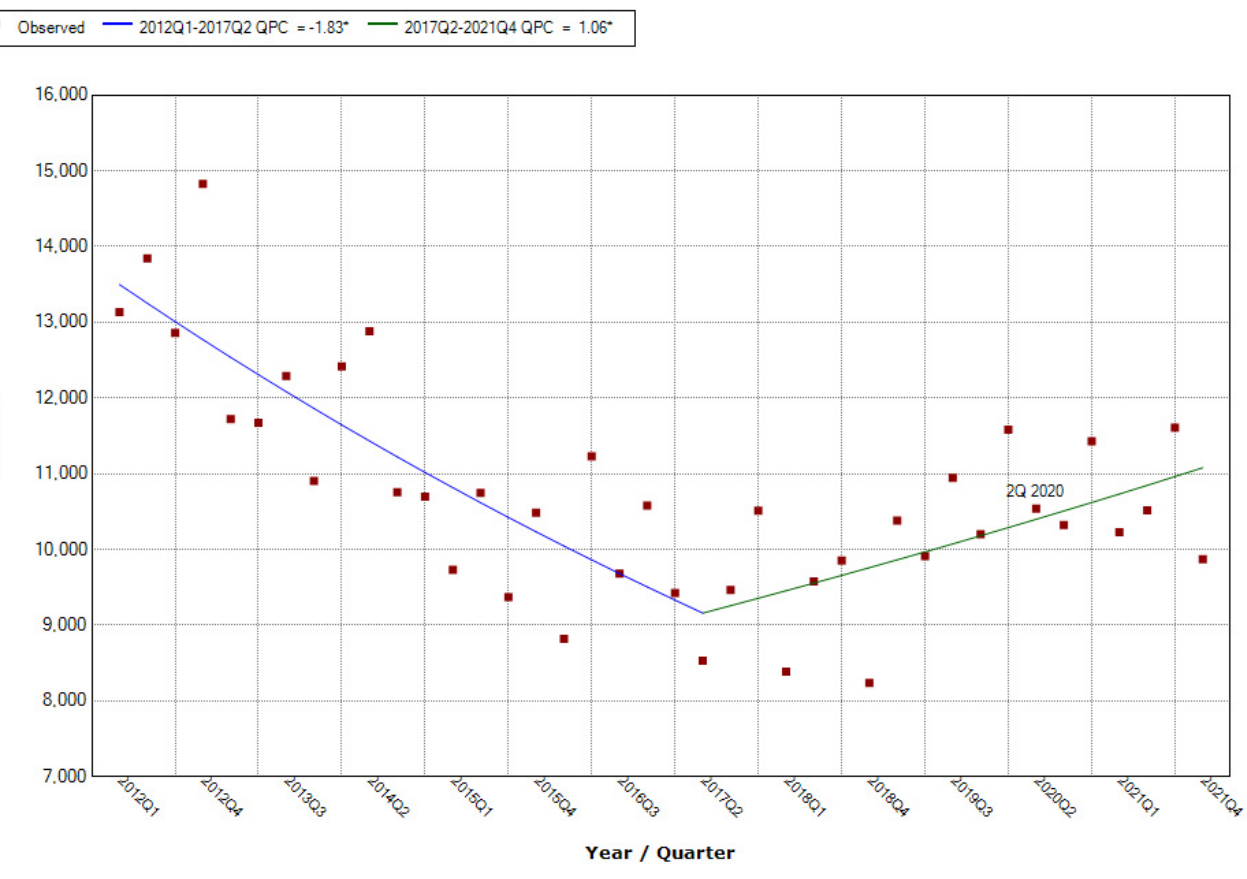
Figure A28. Percentage of products containing vitamin E in individual quarters in the period from 2012 to 28 November 2021. Joinpoints mark trend turning points. The date above the observation indicates the moment of publication of the scientific opinion/resolution.